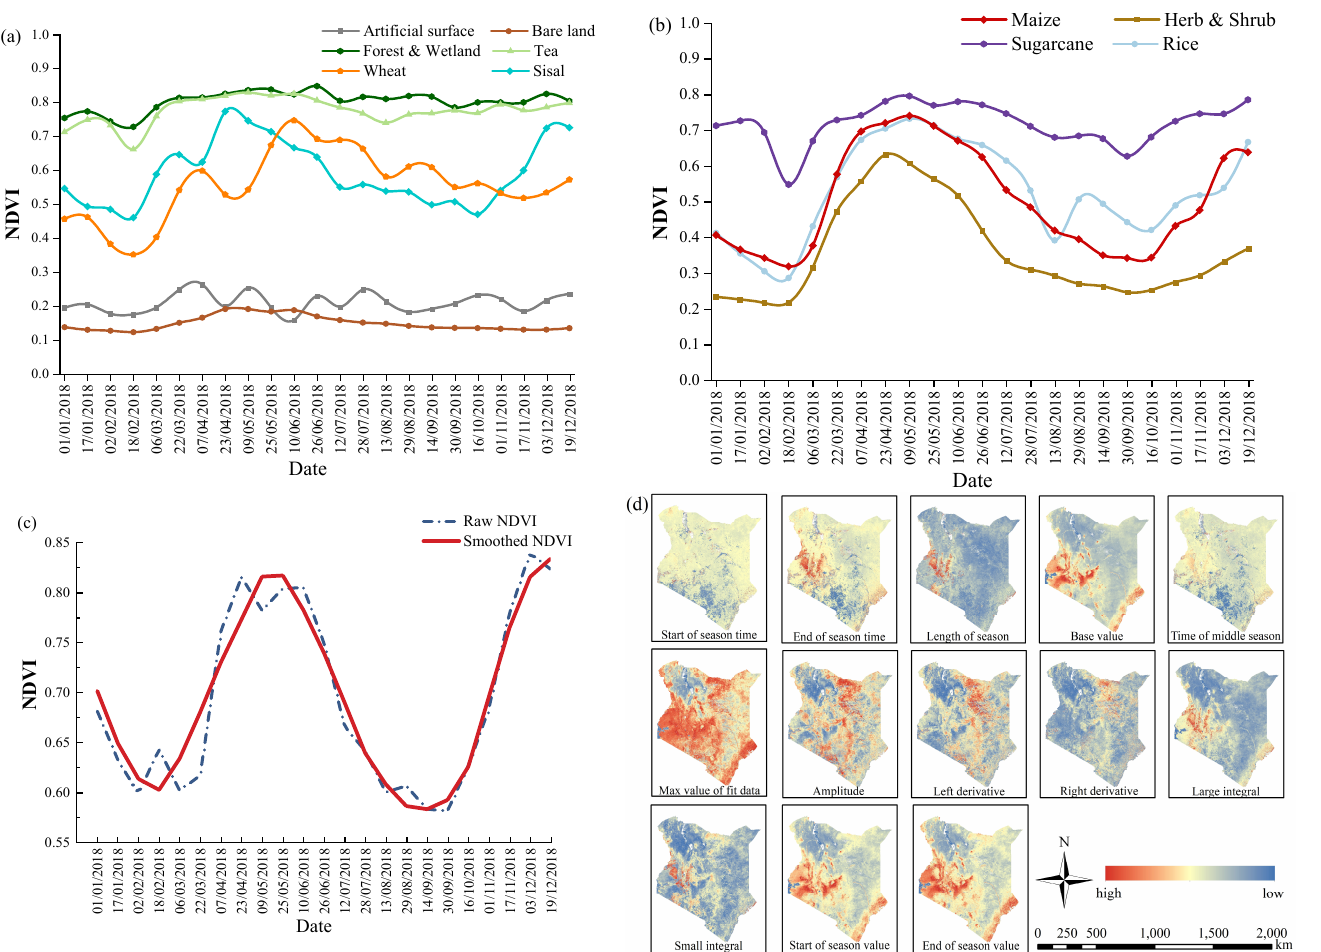
Figure 3. ( a , b ). Annual time series of the mean MODIS NDVI calculated for major land cover types. ( c ) Example of NDVI time series acquired over a maize field pixel, before and after filtering using Savitzky–Golay algorithm. ( d ) Raster data of phenometrics calculated by TIMESAT (obtained from the first growing season).